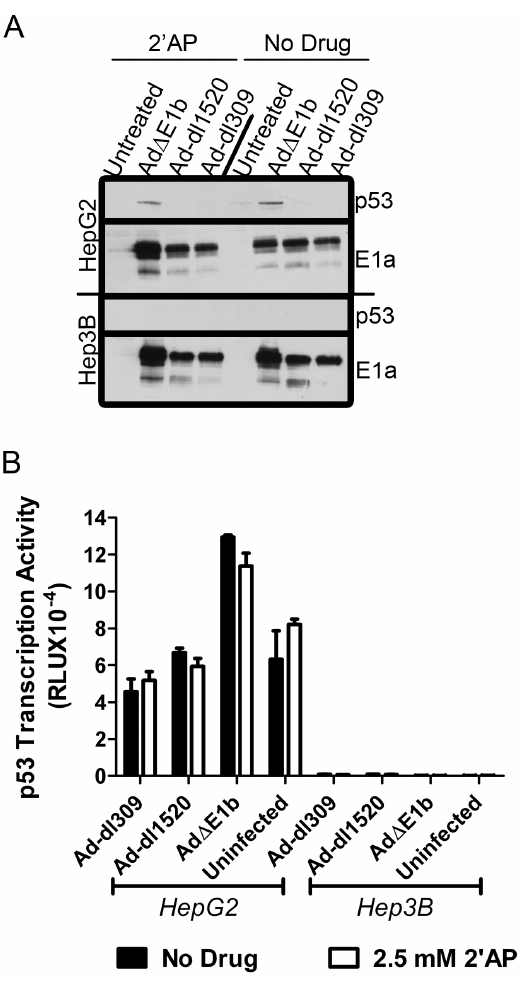
Figure 7. p53 expression and activity were not inhibited by 2 9 AP treatment of infected cells. (A) HepG2 and Hep3B cells were infected with Ad-dl309, Ad-dl1520 or Ad D E1b at MOI of 100 VP/cell and treated with no drug or 2.5 mM 2 9 AP for 2 days. p53 and E1a levels were detected by western blot analysis. (B) HepG2 and Hep3B cells were transfected with a p53-responsive firefly luciferase expression vector. The next day, transfected cells were mock infected or infected with Ad-dl309, Ad-dl1520 or Ad D E1b at MOI of 100 VP/cell and treated with no drug or 2.5 mM 2 9 AP. Luciferase expression was measured 2 days post-infection. Both HepG2 and Hep3B have high transfection efficiencies. Error bars correspond to + / 2 SD of triplicates.